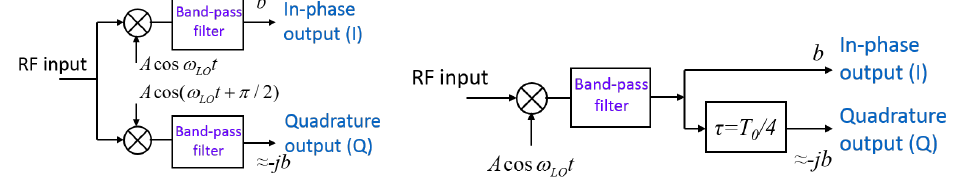
Figure 1. Two systems of implementing a Hilbert transform, or producing a quadrature signal. Left: An analog IQ mixer. Right: Using a quarter period